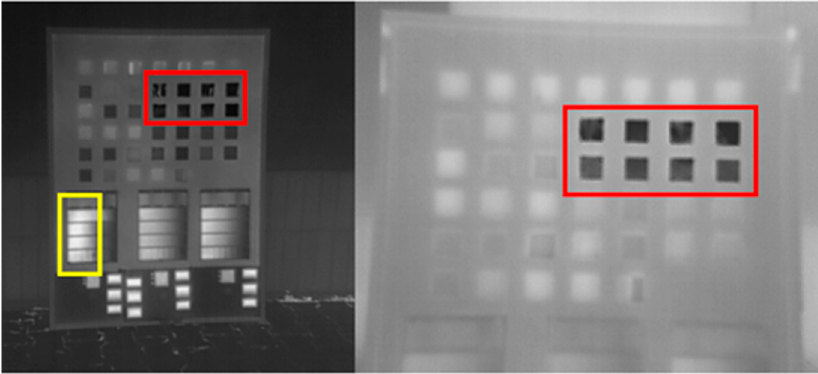
Figure 3. Thermogram of the board with material samples. The red rectangle marks metals, which were characterized by the lowest reflectance. Matte paper placed in the bottom part of the board reflects electromagnetic radiation very weakly (yellow rectangle). The differences in emissivity between the paper and printed ink are too small to ensure appropriate contrast of thermograms. The comparison of emissivity values with the obtained results in the image (Figure 4) allowed for the selection of suitable materials.